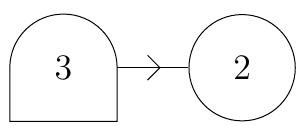
Figure 6 . The dual quiver for the SU(3)[1 ; 2]